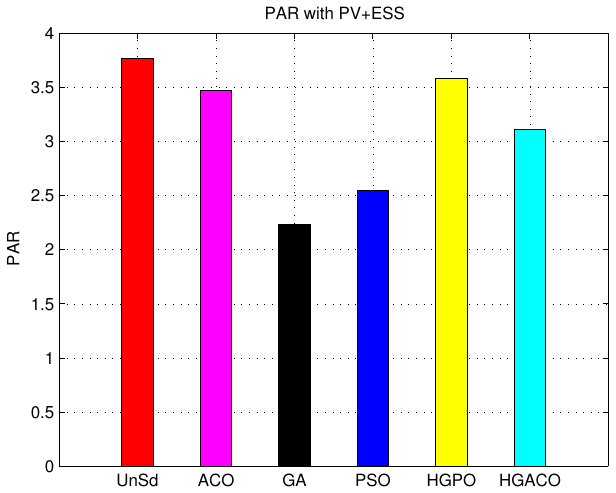
Figure 19. PAR with photovoltaic-battery systems. Table 13. Scenario III: PAR assessment with photovoltaic-battery systems.